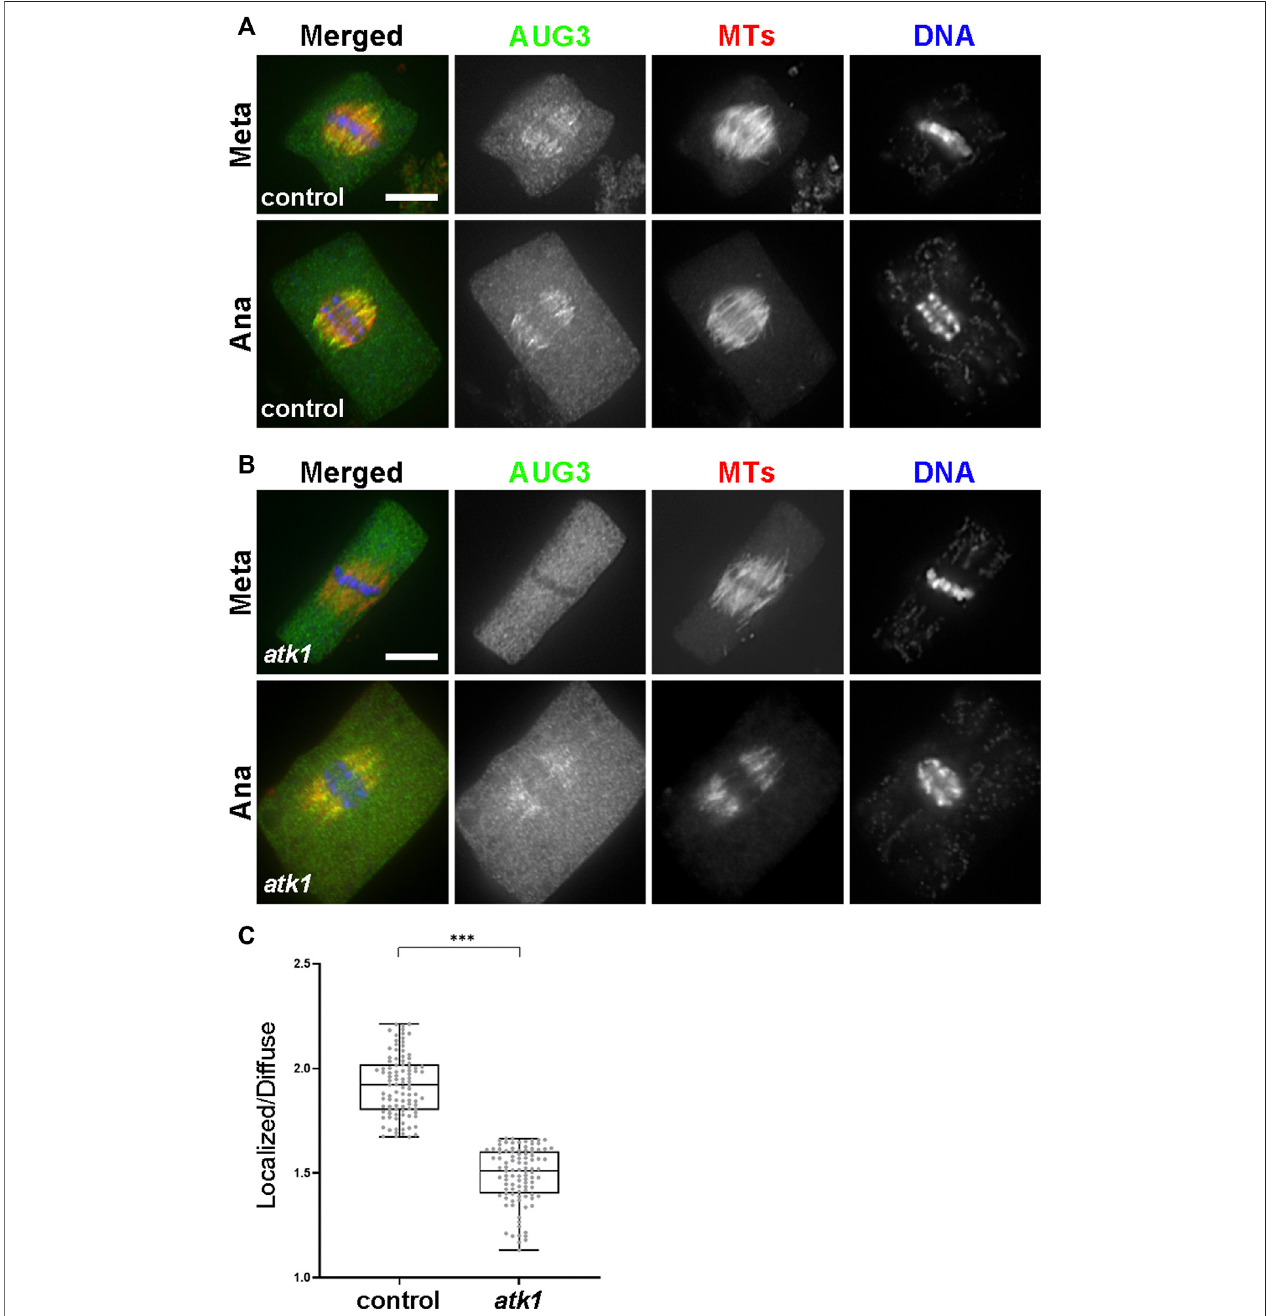
FIGURE9| ATK1playsaroleinaugminassociationwithMTsofthemetaphase spindles. (A) AugminsubunitAUG3showsanenrichedlocalizationonspindleMTs inboththemetaphase (Meta)andanaphase(Ana)cells. (B) Inthe atk1-1 mutant, however,AUG3becomesnoticeablyweakeralongspindleMTswhencompared tothe diffuse signal in the cytosol, which is particularly obvious in the metaphase cell. (C) Quantitative assessment of the MT-localized AUG3 signal, as reported by the ratio of spindle-associated vs. diffuse signals in metaphase cells. The ratios drop sharply in the atk1-1 mutant. Scale bars, 5 µm.